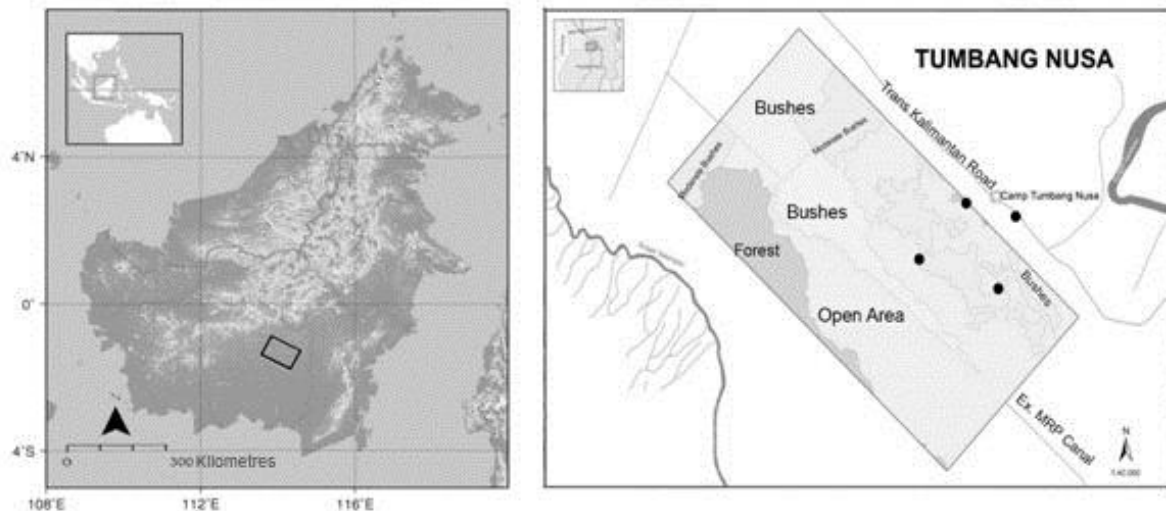
Figure 1. The study sites. A: Tanjung Jabung Barat (Tanjabar) district of Jambi province (on Sumatra); B: Tumbang Nusa in Central Kalimantan province (on Borneo). Black filled circles indicate the locations of plots used in this